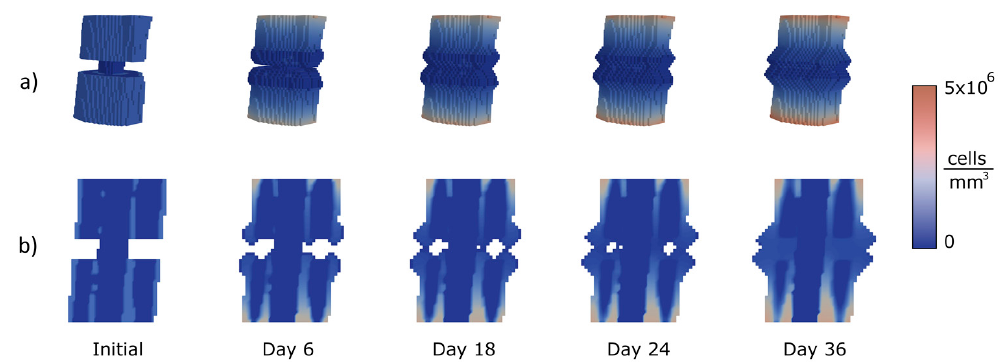
Figure 7. Calculation of concentrations (MSCs) and growth for a transverse fracture with 6 mm gap: ( a ) 3D view of the callus growth process; ( b ) sagittal section along femoral axis. The second case (Figure 8) corresponds to an oblique fracture with a 30 ◦ slope and a gap of 3 mm. The sequence of images shows the evolution of the callus over 40 days. As shown in the figure, the callus starts to grow near the lowest and the highest points of the facture. At day 32, the gap is almost filled but voids remain in its interior. Finally, at day 40 the gap is closed and the callus